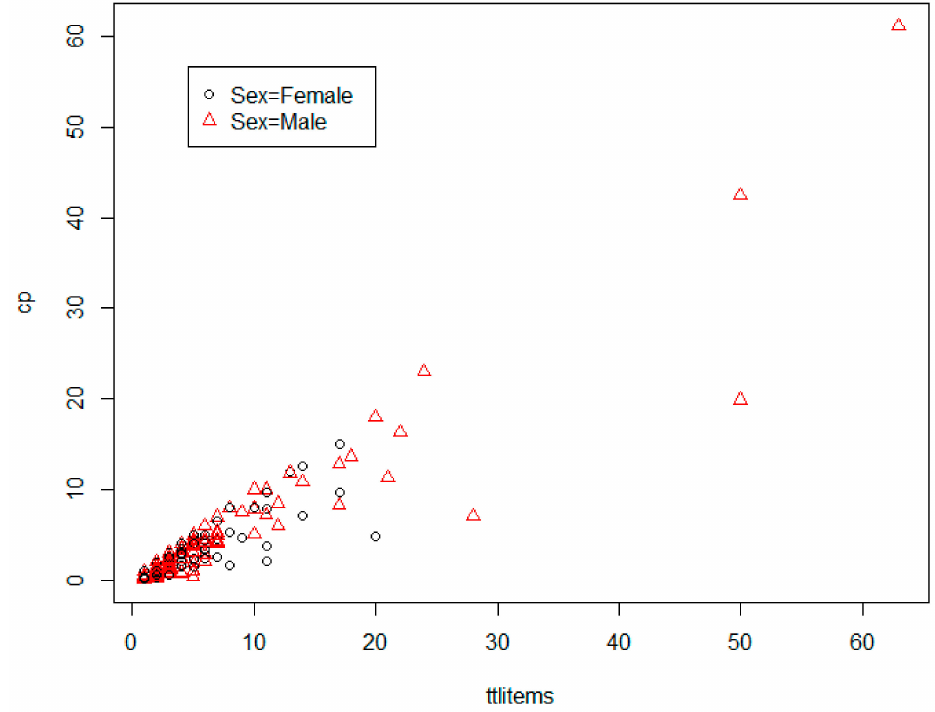
Figure 2. Relationship between nominal productivity and relative productivity by sex.